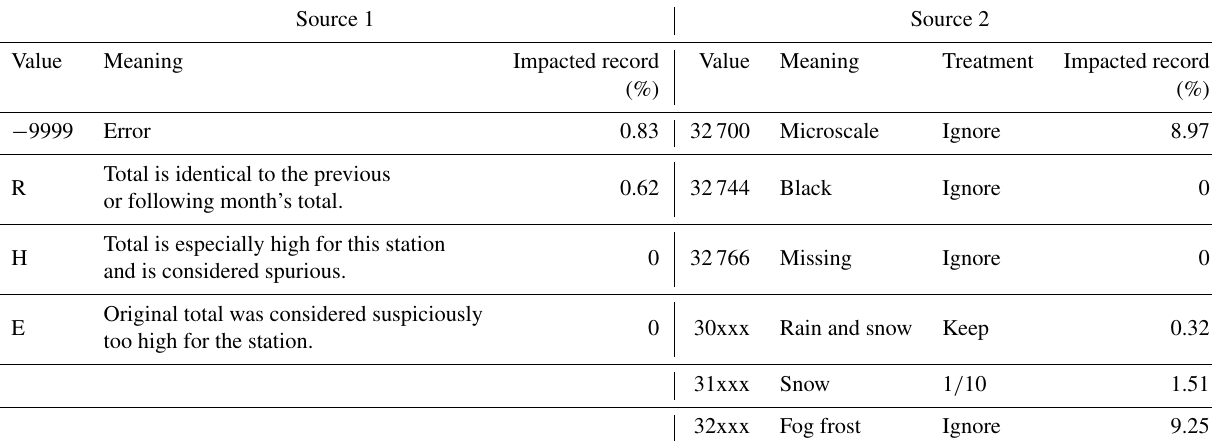
Table 2. Data information description table (source 1: https://rda.ucar.edu/datasets/ds578.5/docs/ndp039.des, last access: 10 April 2019; source 2: